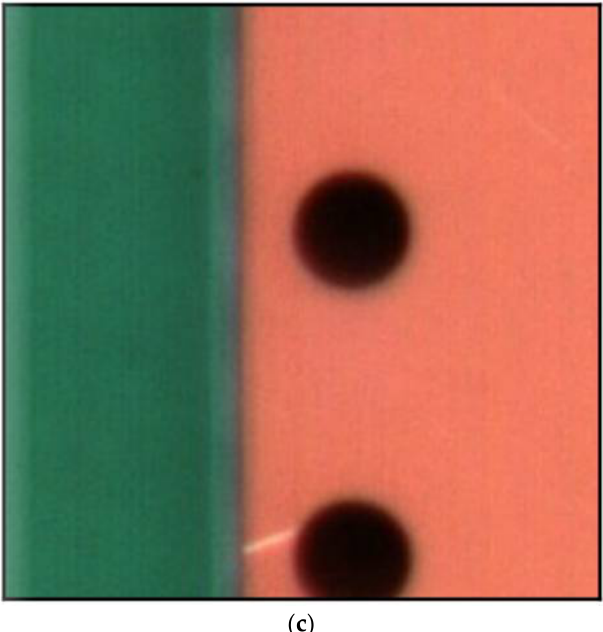
Figure 3. False negative PCB example. ( a ) False negative example 1; ( b ) False negative example 2; ( c ) False negative example 3.